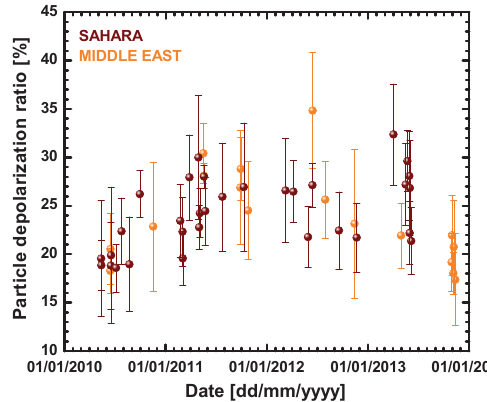
Figure 2. Free-tropospheric dust layer mean particle linear depolar- ization ratio of all 32 Saharan dust (brown circles) and 17 Middle East dust cases (orange circles). The shown SDs (vertical bars) in- dicate the vertical variability within each layer in terms of the FT depolarization